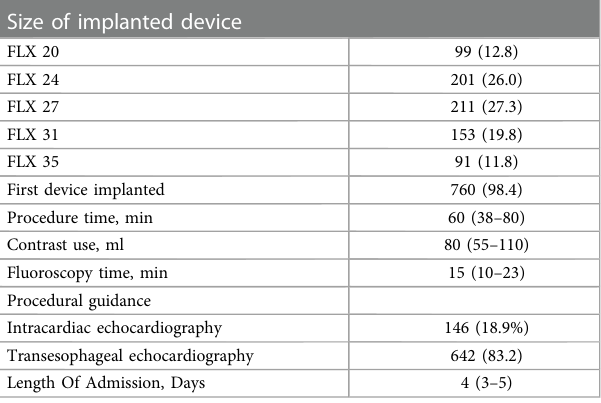
TABLE 2 Procedural characteristics ( N